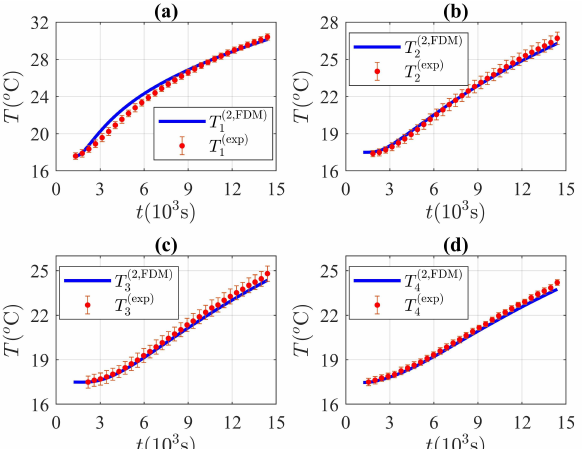
Figure 7. Time evolution of the temperature at each thermocouple radial position according to the the experimental and numerical results. Experimental values of the average temperature at each radial coordinate ( a ) r 1 = 4.1cm, ( b ) r 2 = 5.8cm, ( c ) r 3 = 7.5cm and ( d ) r 4 = 9.2cm, respectively are shown in red circles and the result obtained through the FDM is shown in solid lines. The numerical result was obtained through the solution of the model described by Equations (9), (14) and (15) and through the set of thermodynamic variables k (cid:96) , k s , C (cid:96) and C s with the lowest quadratic error shown by Equation